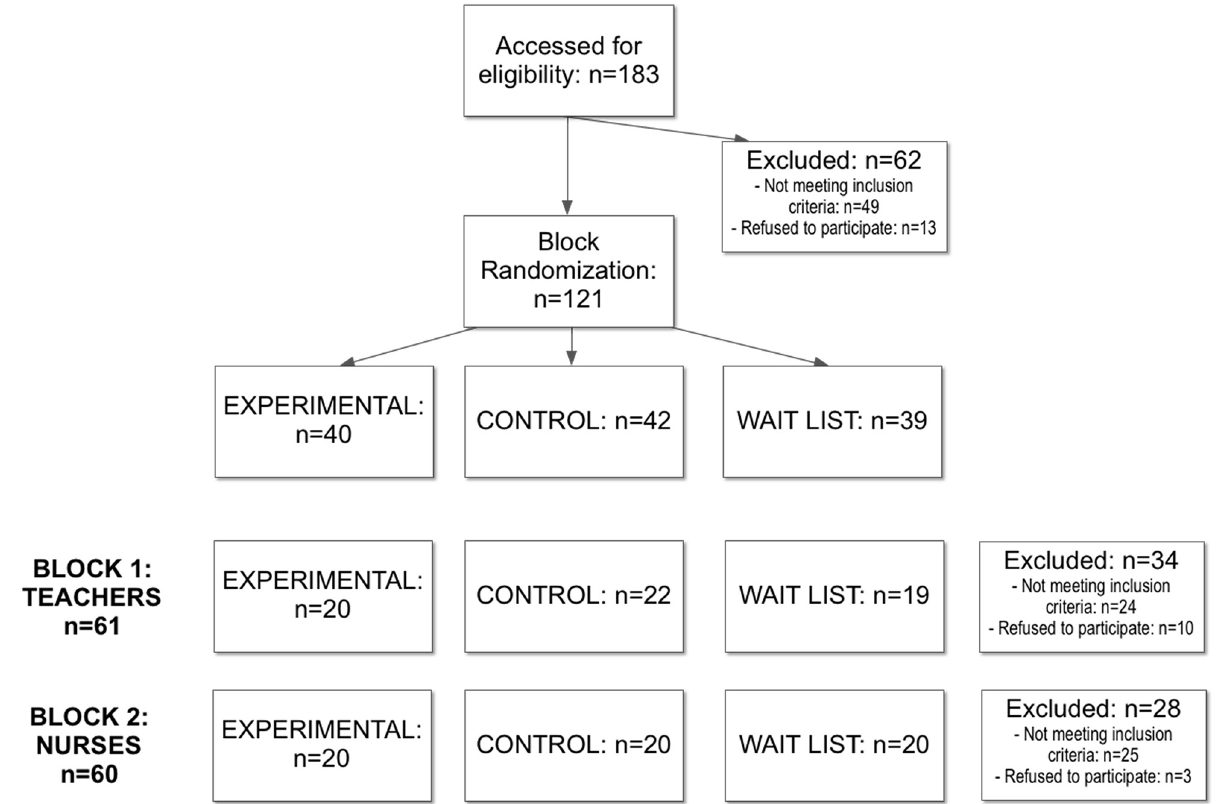
Figure 3. Consort